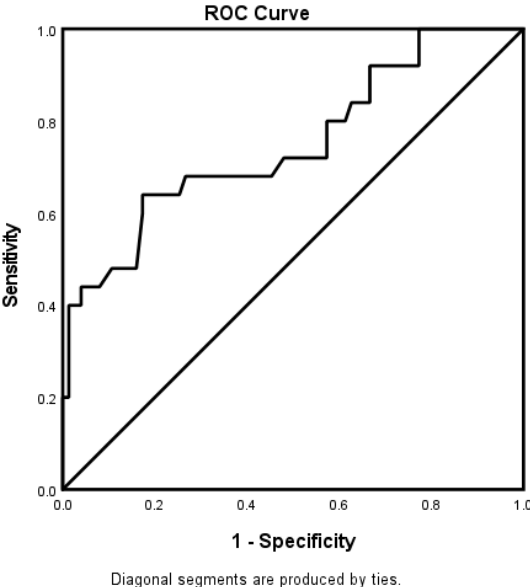
Figure 4. ROC curve associated with stroke severity in 65–74-year-old patients. Hosmer–Lemeshow test: p = 0.676; Cox and Snell: R2 = 0.098. The overall classified percentage of 76.3% was applied to check the fi tness of the logistic regression model. * indicates statistical signi fi cance ( p < 0.05) with a 95% con fi dence interval.